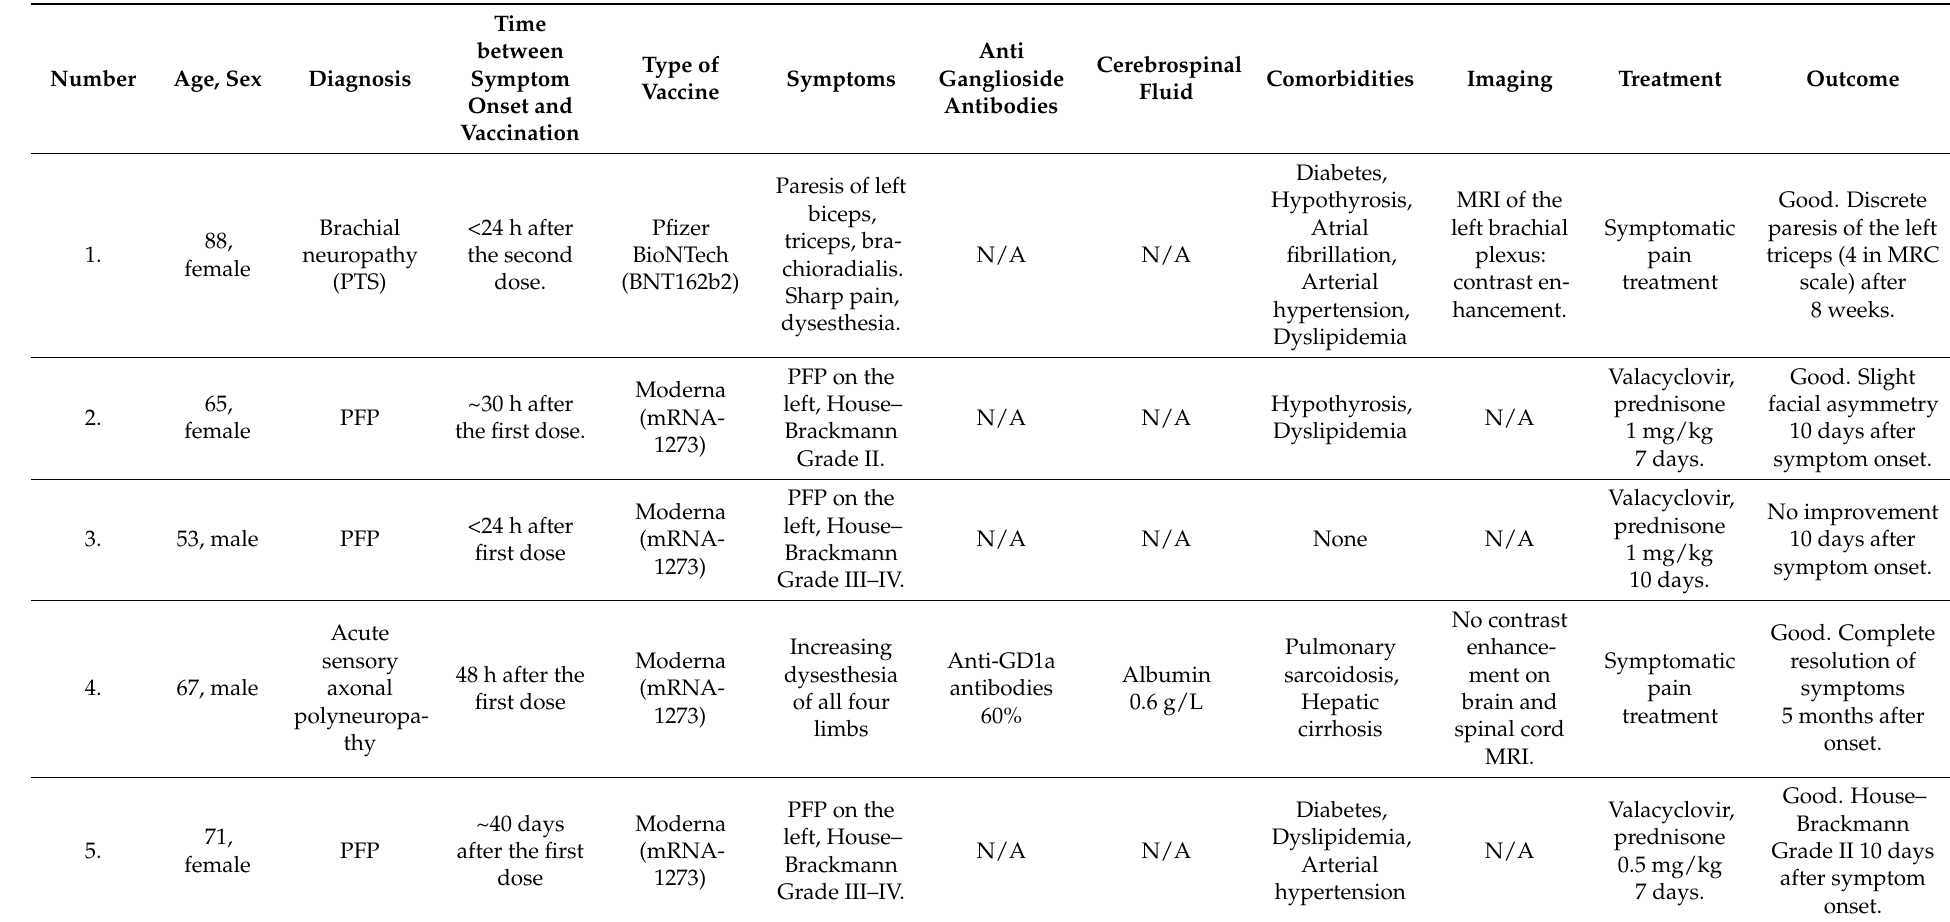
Table 1. Profile of Neuropathy